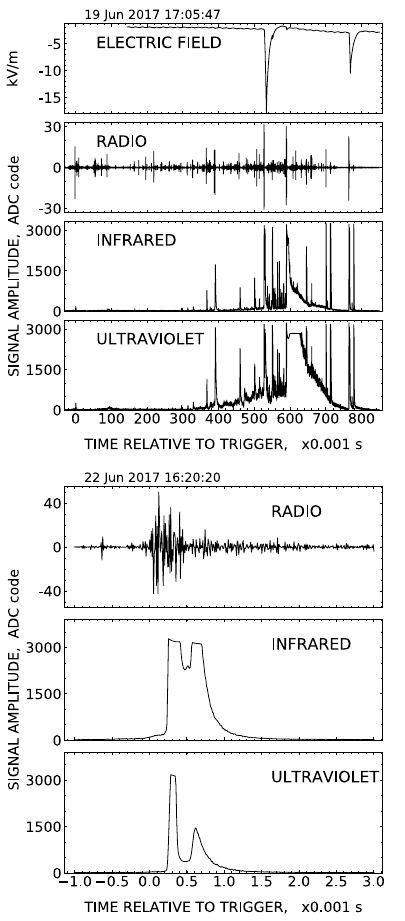
Figure 4. High resolution records of the lightning discharge con- nected electromagnetic radiation in radio and optic wave ranges. Zero point of the time axes corresponds to beginning moment of electric